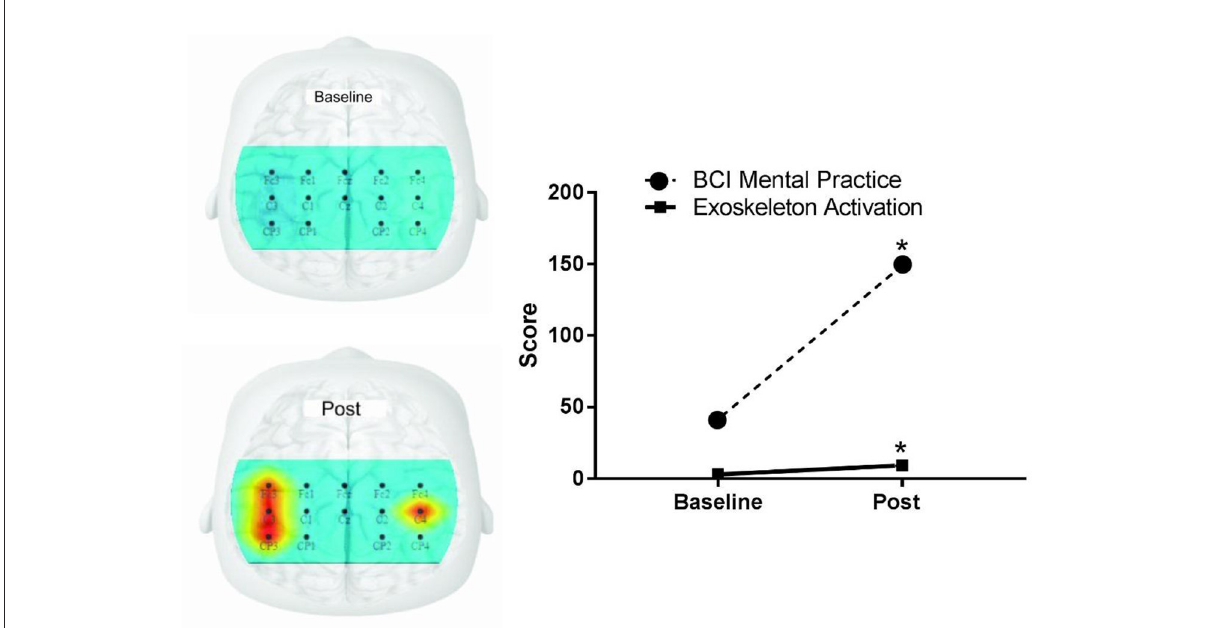
FIGURE4 Activation of the premotor cortex, primary motor, primary somatosensory brain areas, degree of motor imaginary, and exoskeleton activations through imagination. BCI, brain-computer interface. The image represents the target brain areas of the premotor cortex, primary motor, and primary somatosensory, measured using the 10-10 electroencephalogram system. The hot color indicates greater activation in both cerebral hemispheres. Skeletal activation indicates how many times the orthosis has been moved through thought.